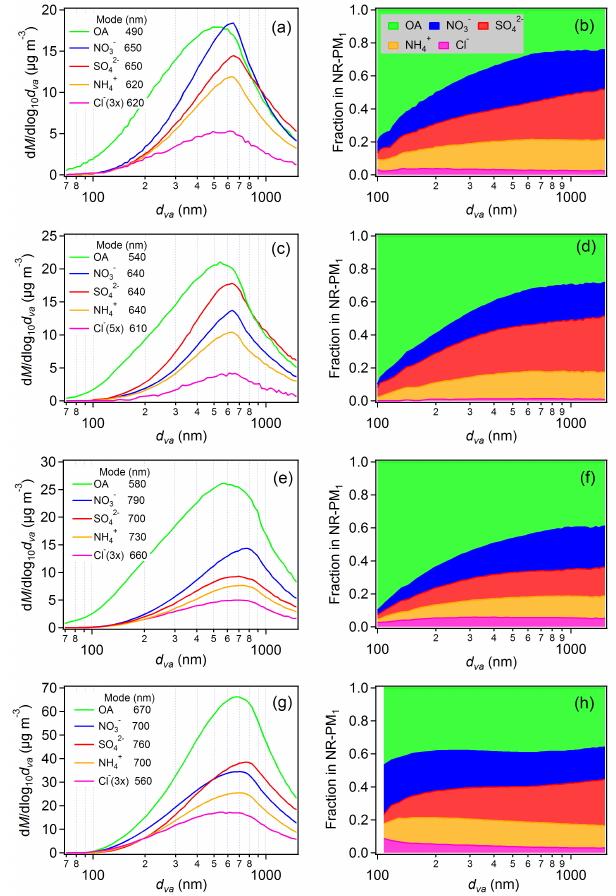
Figure 4. Mass size distributions of chemical compositions in NR- PM 1 during the spring (a, b) , summer (c, d) , autumn (e, f) , and winter (g, h)